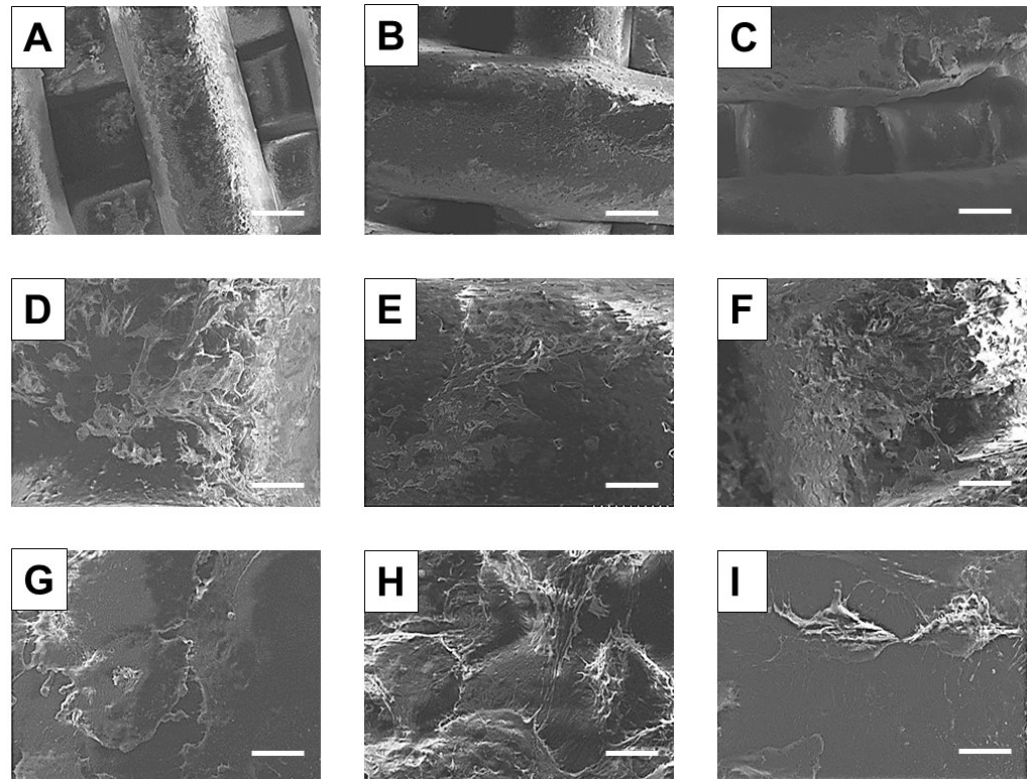
Figure 9. SEM micrographs of U2OS cells seeded on PCL ( A , D , G ), PCL / 10Sr-nHA ( B , E , H ) and PCL / 20Sr-nHA ( C , F , I ) after 14 days in culture; (( A – C ) scale bar = 200 µ m; ( D – F ) scale bar = 40 µ m; ( G – I ) scale bar = 8 µ m).